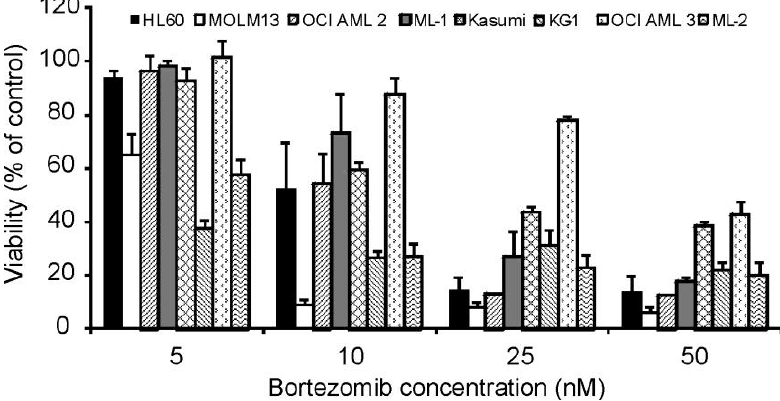
Figure 2. AML cell lines are highly sensitive to bortezomib. AML cell lines were treated with 5, 10, 25 or 50 nM bortezomib for 24 h after which cell viability was measured by MTT assay. Values are expressed as a percent of untreated cells and presented as mean ±